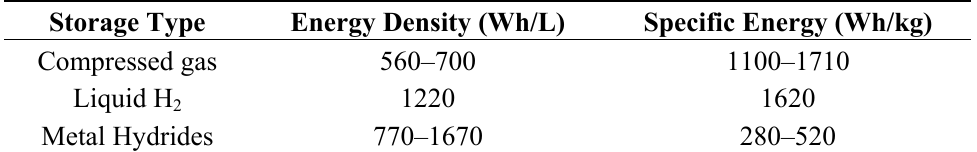
Table 3. Hydrogen storage system energy content (based on